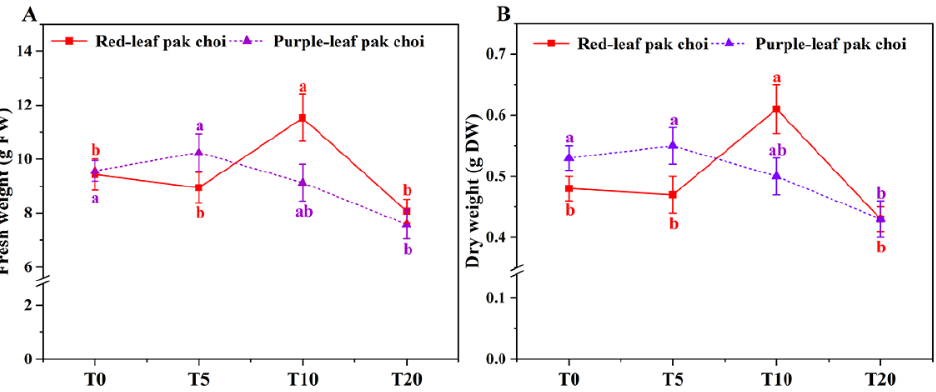
Figure 3. Effects of blue and UVA light on the fresh weight ( A ) and dry weight ( B ) of red- and purple-leaf pak choi. T0, T5, T10 and T20 mean 0 UVA with 50 B, 5 UVA with 45 B, 10 UVA with 40 B and 20 UVA with 30 B (μmol·m − 2 ·s − 1 ), respectively. Different letters mean statistical differences determined with Duncan’s multiple test at p < 0.05 among treatments. Error bars indicate ± SE ( n = 3).